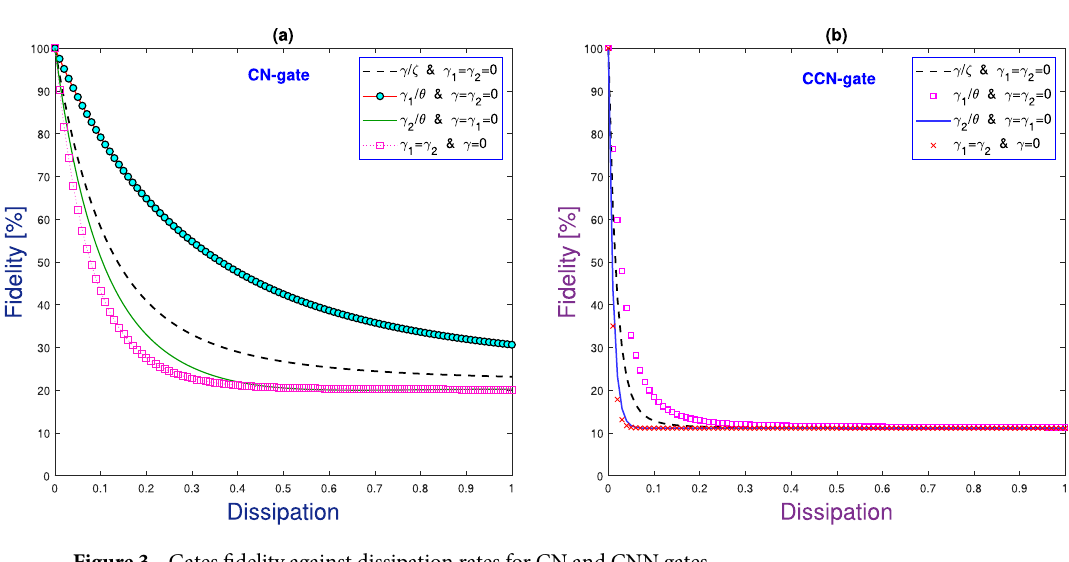
Figure 3. Gates fidelity against dissipation rates for CN and CNN